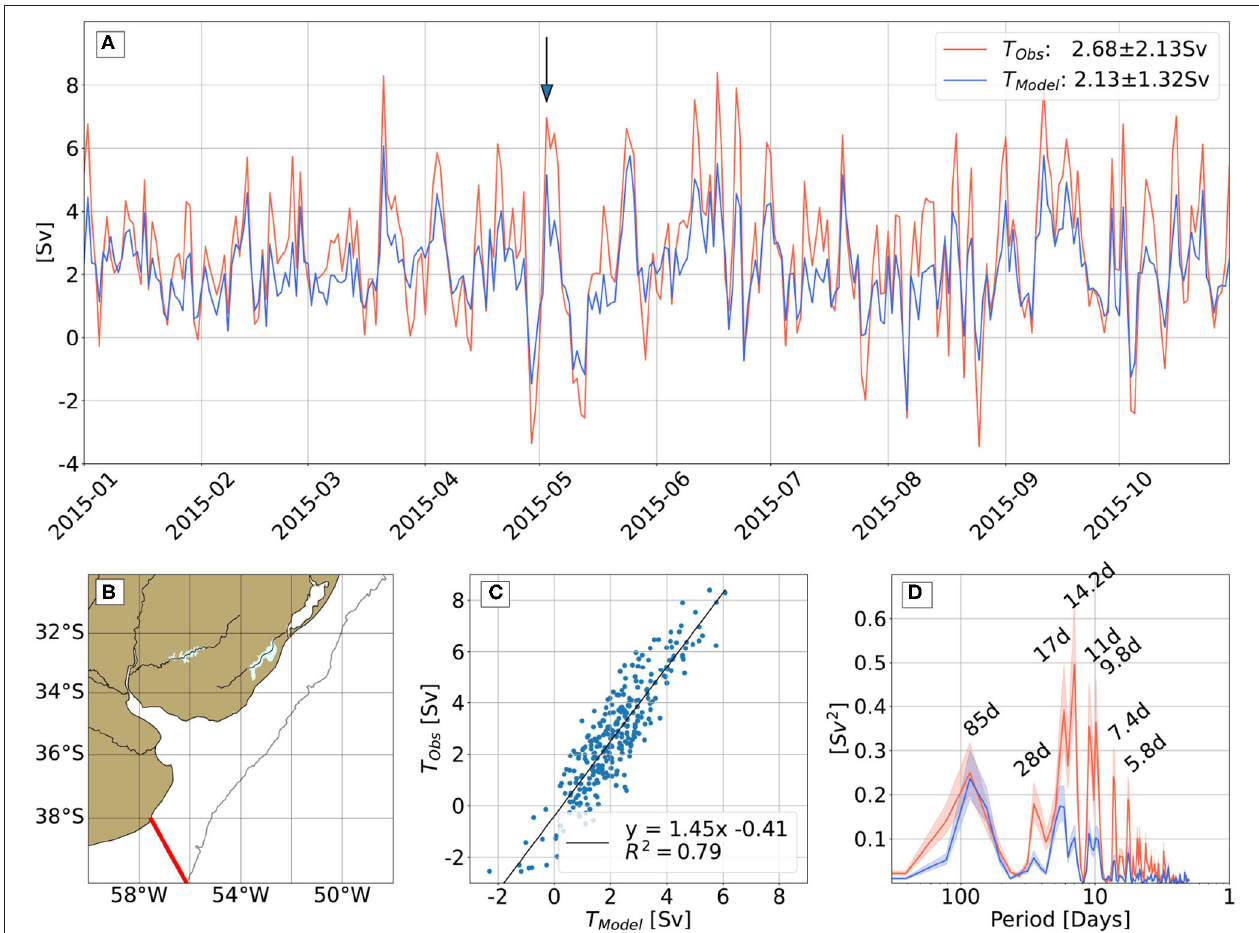
FIGURE 4 | (A) Daily observational ( T Obs , red) and model-derived ( T Model , blue) shelf transport (Sv) across the red line shown in (B) . (C) T Obs vs. T Model , and linear regression (black line). (D) Power spectrum of T Obs (red line) and T Model (blue line) with bands of 95% confidence levels